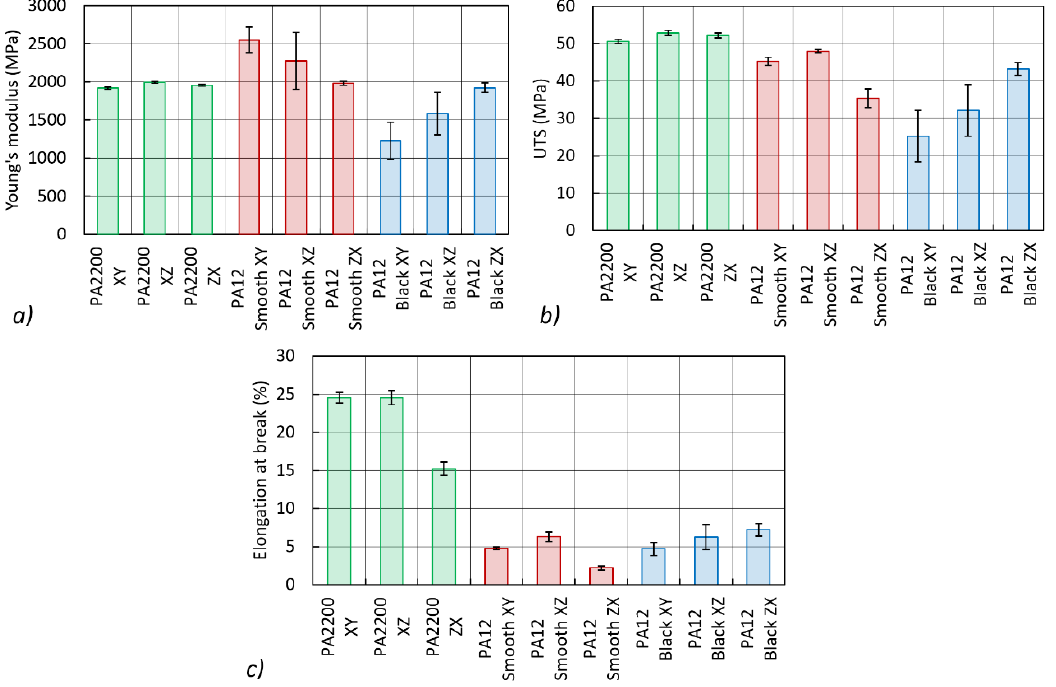
Figure 6. Benchmark and tensile specimens produced using ( a ) Formiga P110 and PA2200, ( b ) Lisa and PA12 Smooth, ( c ) S1 and PA12 Black.